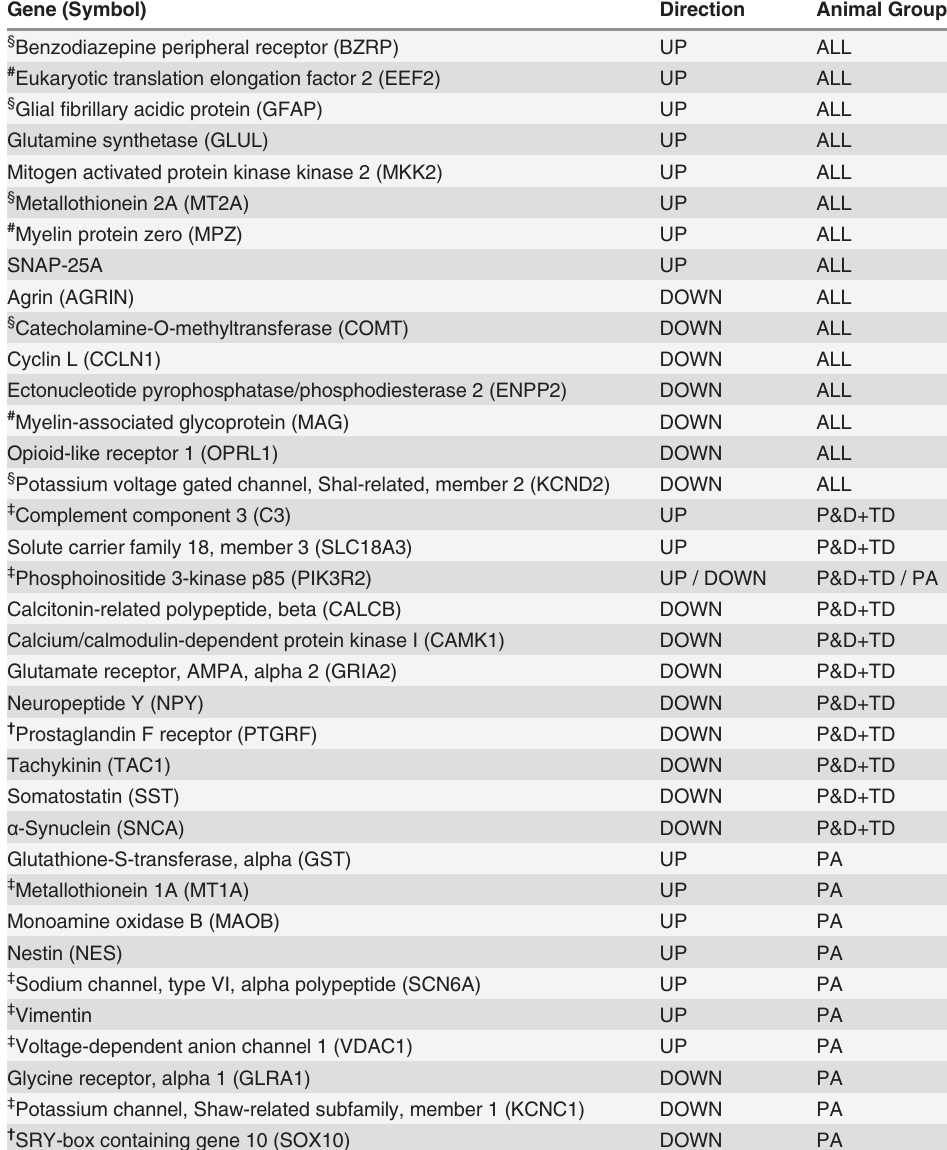
Table 2. A summary of all of the genes up- or down-regulated in the lumbar spinal cord of rats 2 days after CCI determined by MAS v5.0. ALL indicates ‘ injury-related ’ genes, with regulation occuring in all rats following